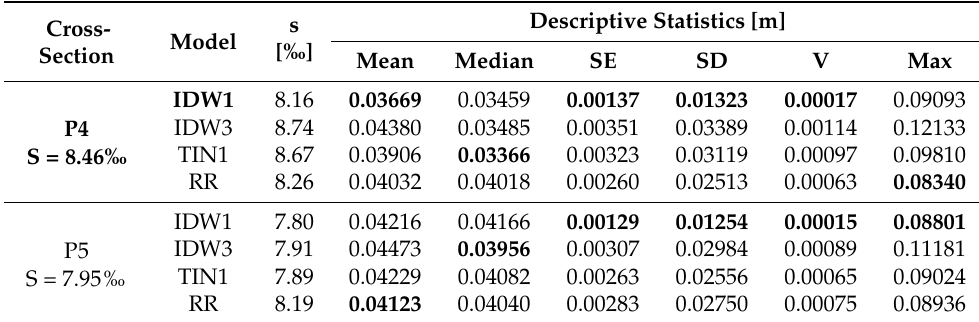
Table 5. Descriptive statistics of absolute deviation of considered models (cross-sections P4 and P5) from the average linear